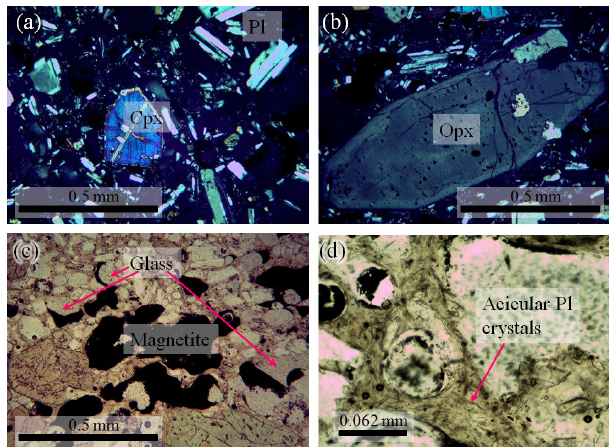
Figure 9. Texture and mineral assemblage of a juvenile, low- density scoria bomb revealed by optical microscope. The mineral assemblage consist of plagioclase (Pl), clinopyroxene (Cpx) and or- thopyroxene (Opx) crystals, as seen in cross-polarised light (a, b) . (c) Magnetite and volcanic glass vesicles observed in plane- polarised light. (d) Cryptocrystalline groundmass with acicular Pl crystals observed in plane-polarised